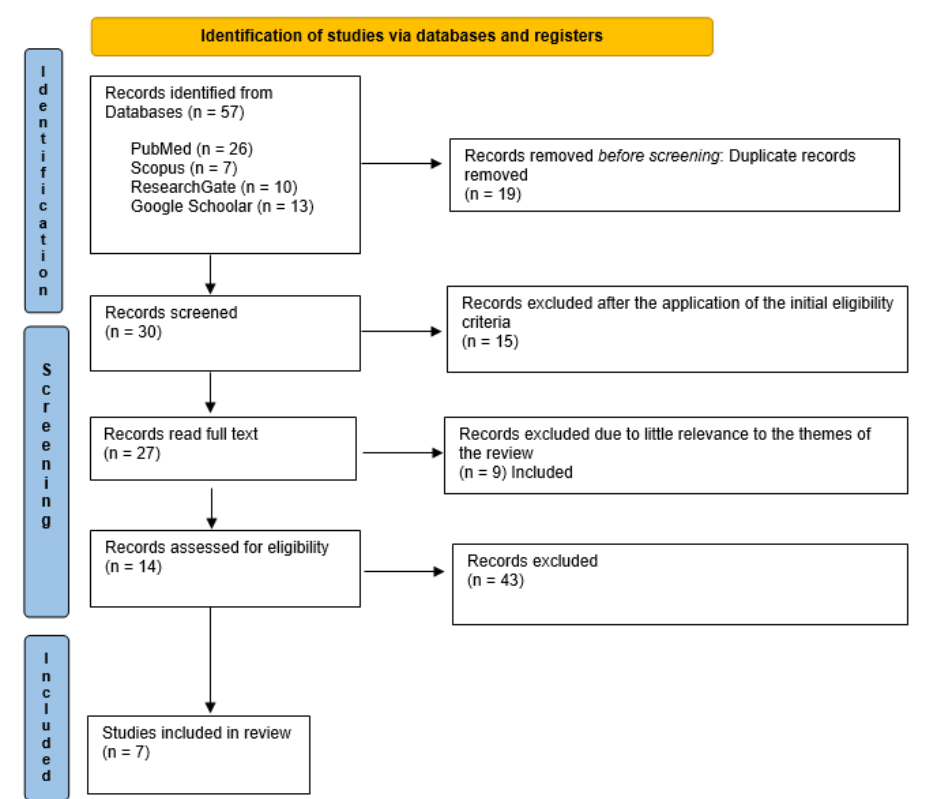
Figure 2. PRISMA flowchart diagram of the inclusion process.